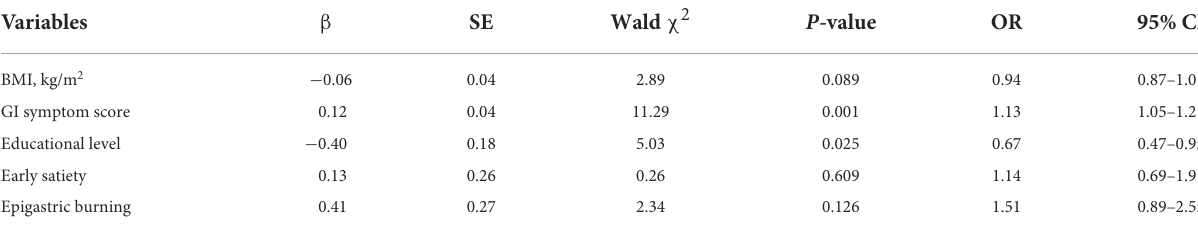
TABLE 2 Multivariate analysis of risk factors for mood disorders in patients with functional dyspepsia. Variables β SE Wald χ 2